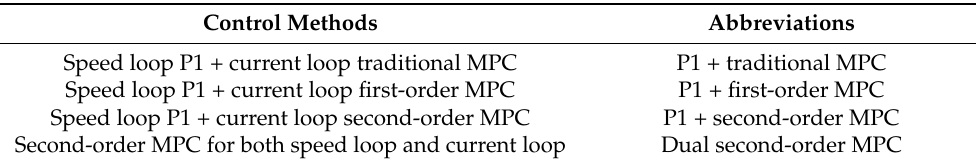
Table 2. Control methods and their